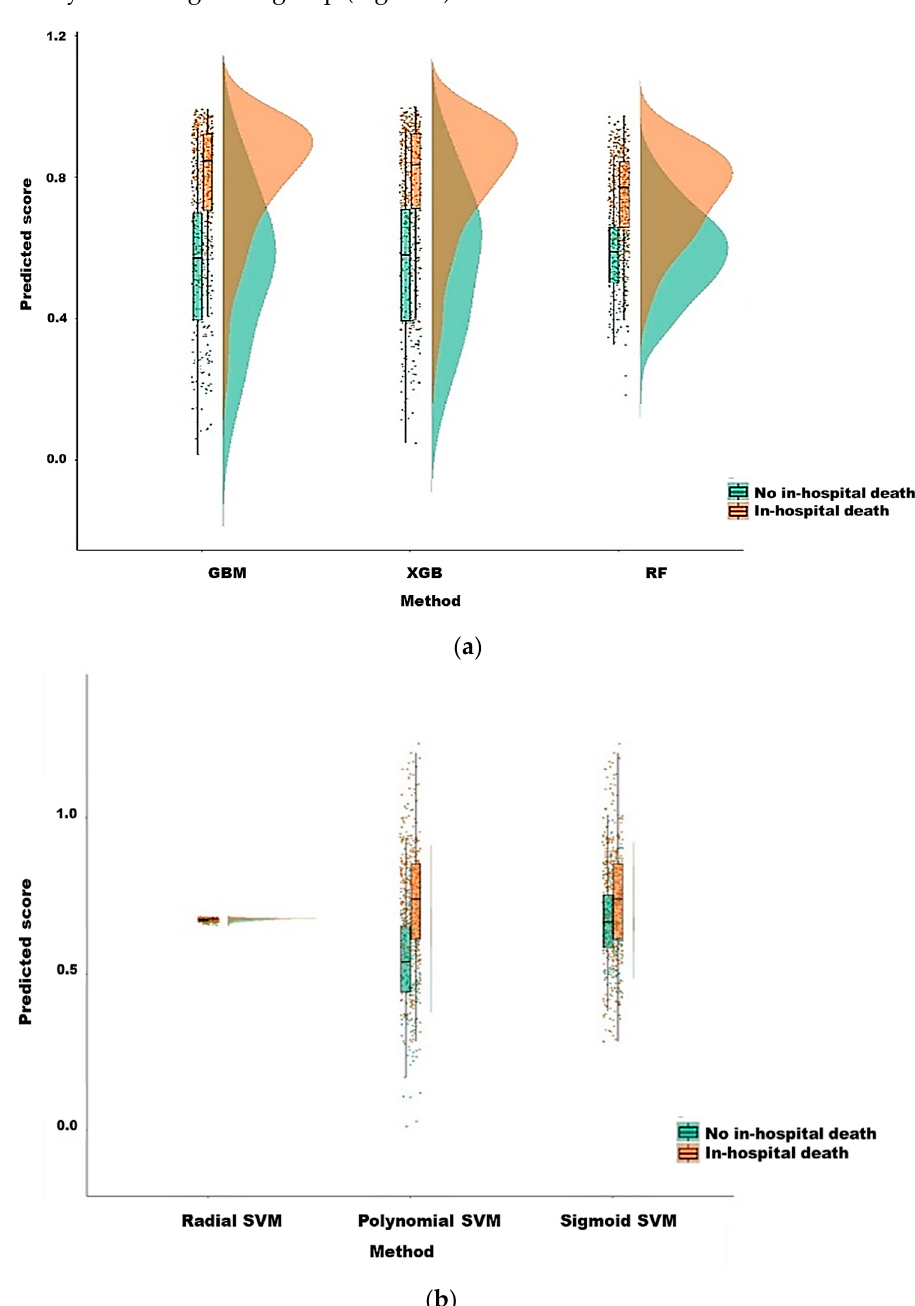
Figure 4. The raincloud plot of in-hospital mortality predicted score in machine learning methods. ( a ) GBM, XGB and random forest, ( b ) SVM with radial kernel, SVM with polynomial kernel, and SVM with sigmoid kernel.